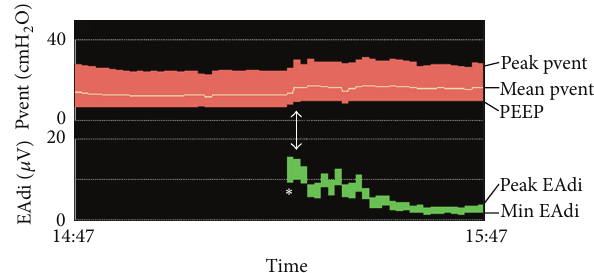
Figure 4: Example of very high level of tonic EAdi ( ∗ ) observed in a 2-year-old boy with acute respiratory distress and hypoxemia. Tonic EAdi rapidly decreased following the increase in PEEP from 7 to 10cm H 2 O (arrow) (see text for